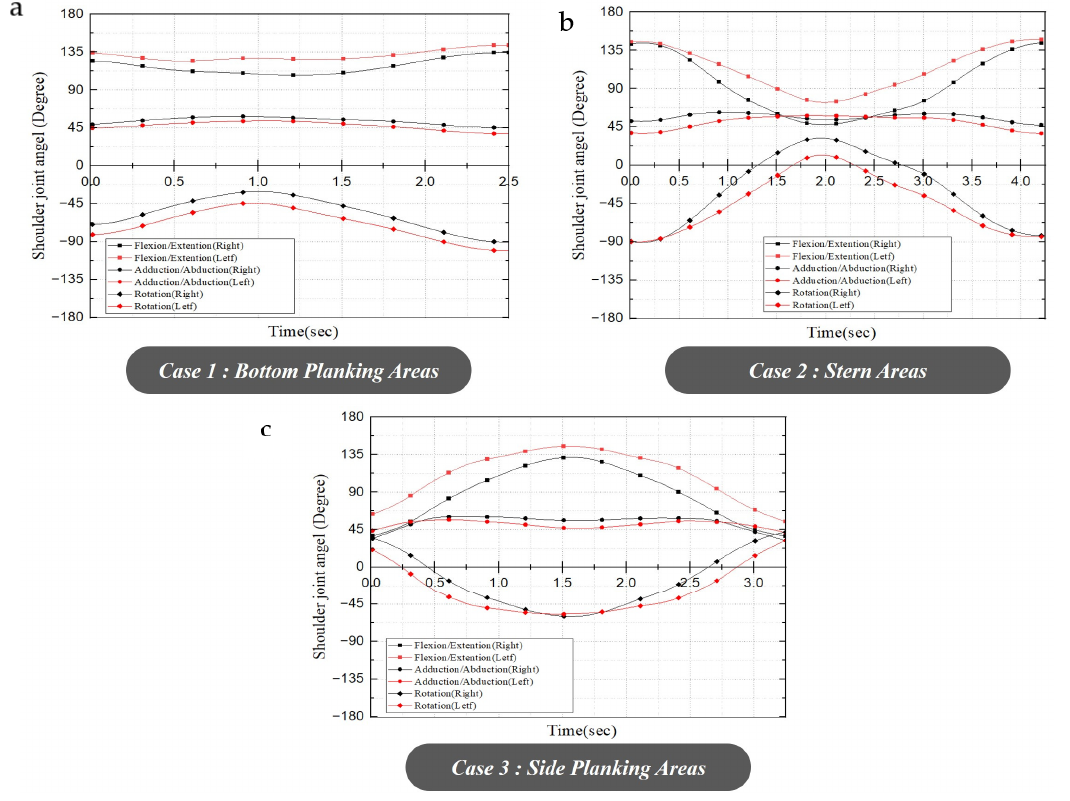
Figure 3. Changes in shoulder joint angle at motion capture: ( a ) bottom planking areas; ( b ) stern areas; ( c ) side planking areas.